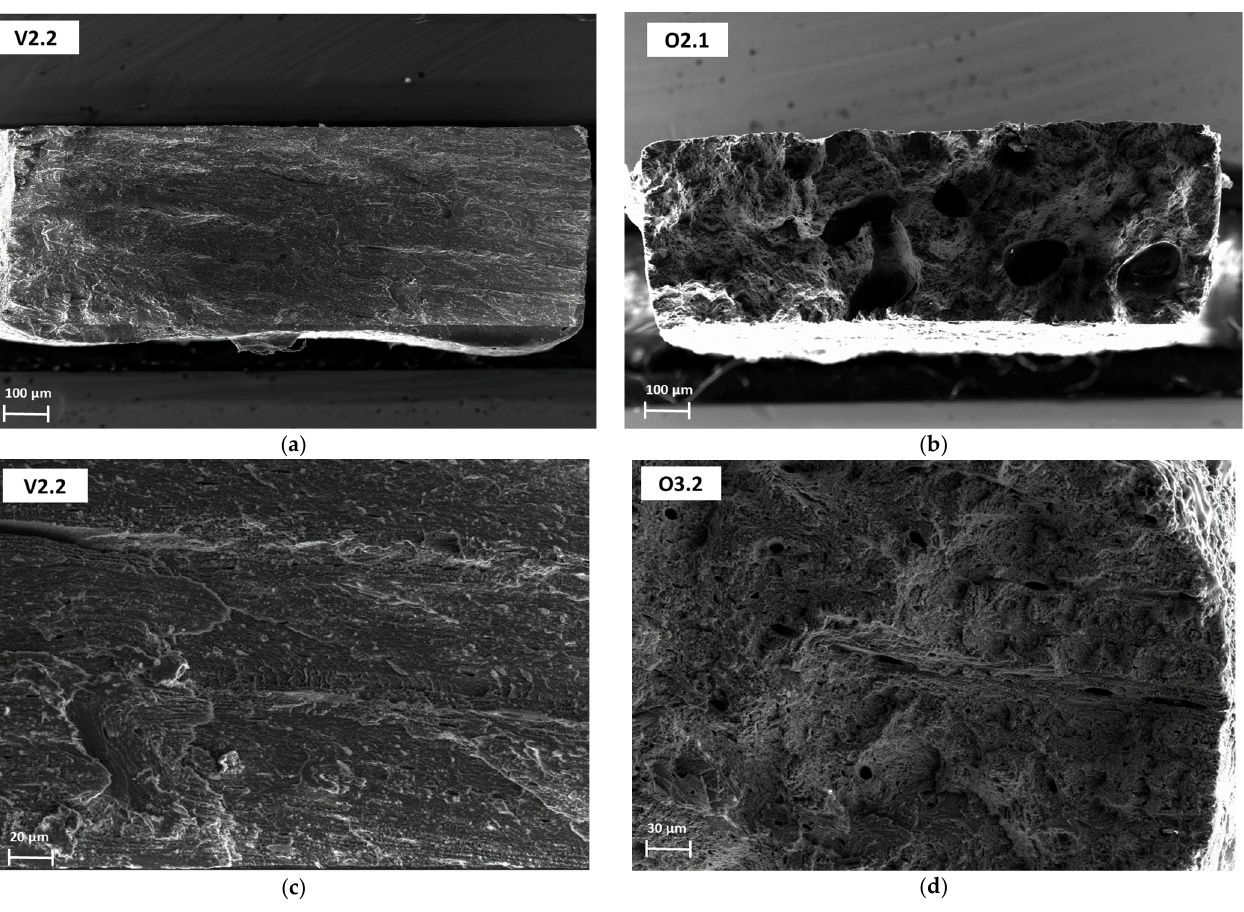
Figure 6. SEM fractographies of dog bone coupons cross sections that were tested under tensile loads. ( a , c ) show surface fractures of bovine samples, which almost do not show any signs of porosity. On the other hand, ( b , d ) belong to ovine bone coupons. As can be observed, these samples show high porosity content, which directly affects bone stiffness.